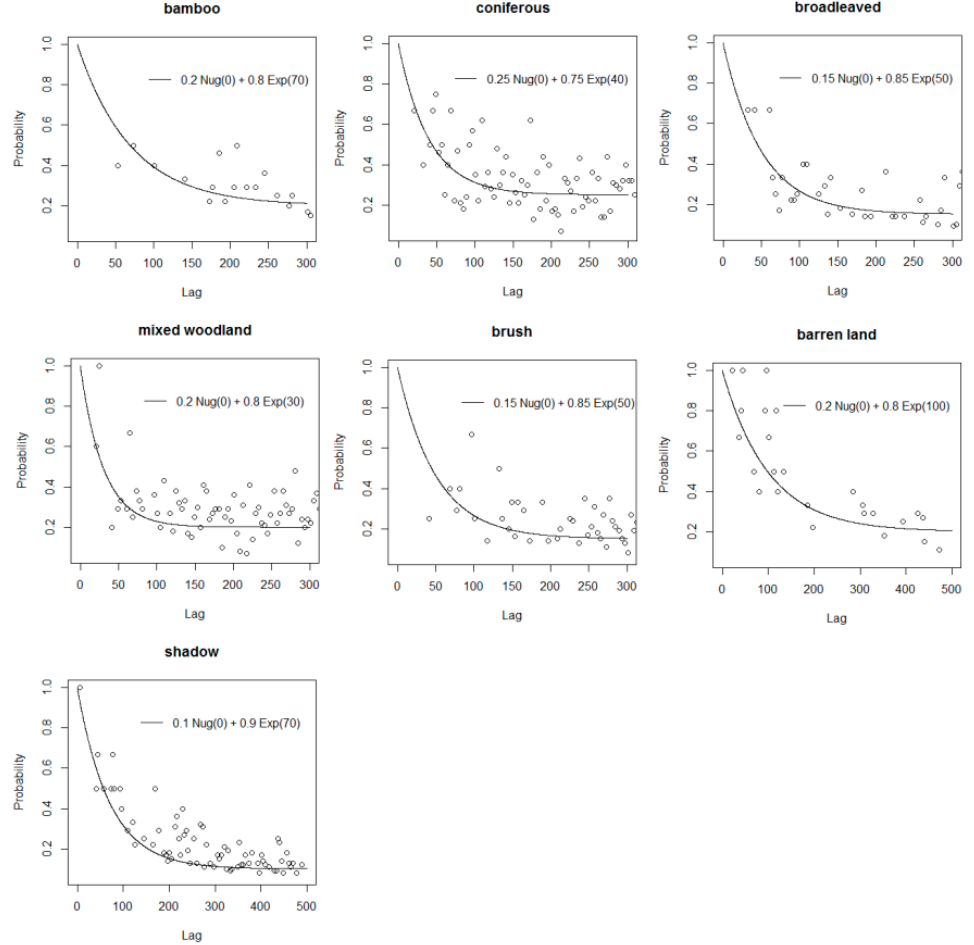
Figure 11. Estimated class-conditional probability plots and fitted models for each class. The lag on the x -axis is in units of pixels.